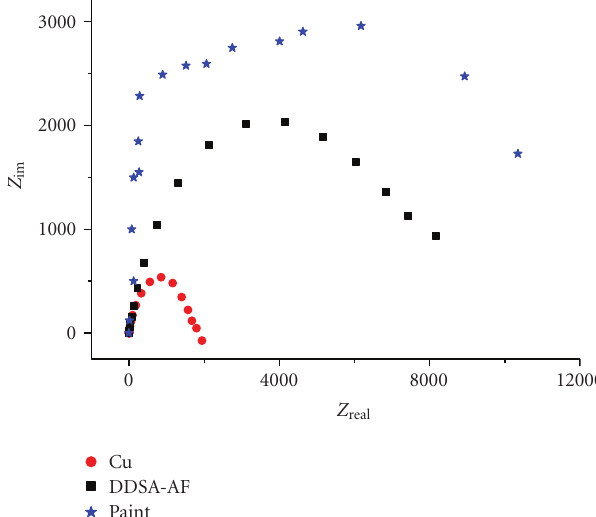
3.1. Scanning Electron Microscope. Figure 6 show surface SEM images of the bare (a) and DDSA resin coated (b) SS electrodes, respectively. Coatings have continuous spaghetti- like structure. The morphology of the coating appeared to be independent of the underlying metal and the films are homogeneous and